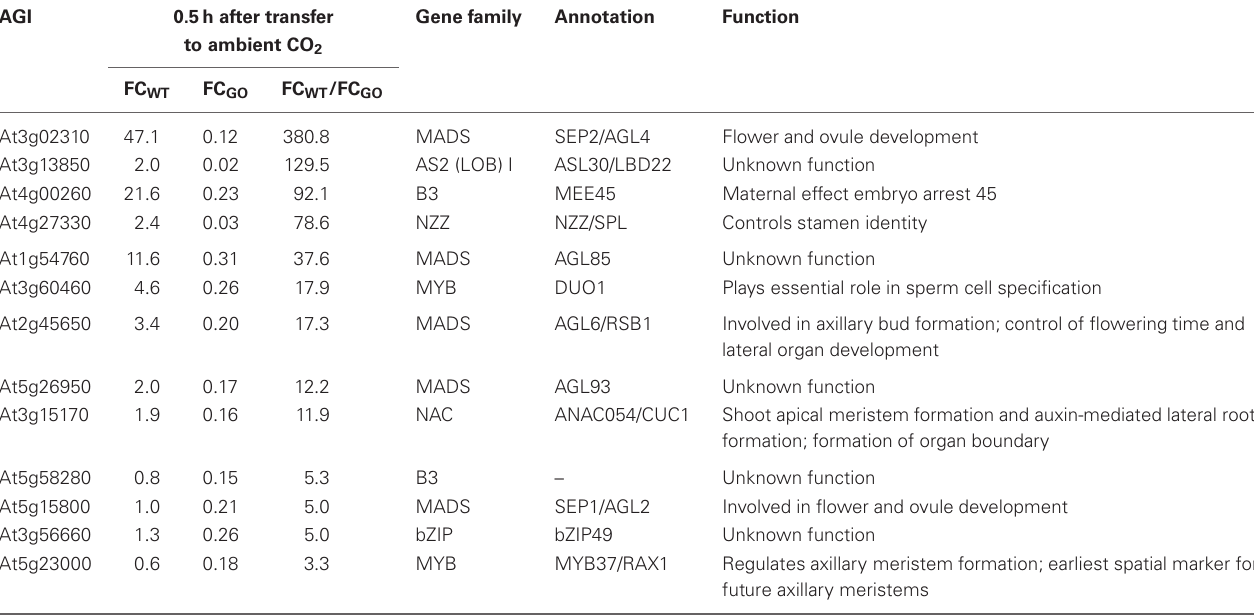
Table 5 | Transcription factors the expression of which was reduced by more than 3-fold in GO plants 0.5h after shifting plants grown at high CO 2 concentration to ambient CO 2